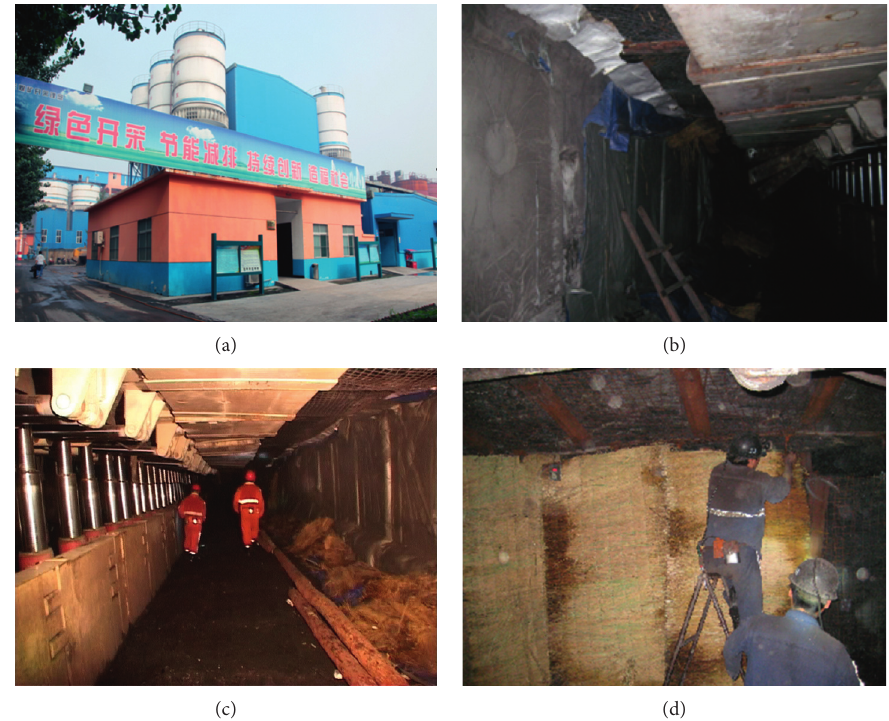
Figure 11: Photographs of the fully mechanized CCGPB technology in the field. (a) Paste preparation plant. (b) Field paste. (c) Backfilling region. (d) Artificial isolation.